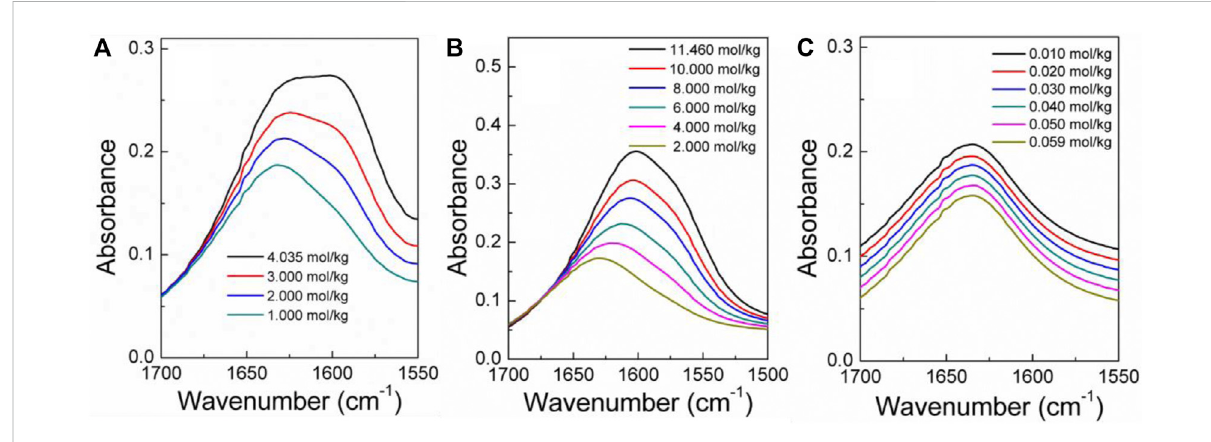
FIGURE 9 Infrared spectra (A – C) of L -serine, DL -proline, and L -glutamic acid aqueous solutions in the range of v (C=O). (A,B) Actual curve. (C) Elevated curve.